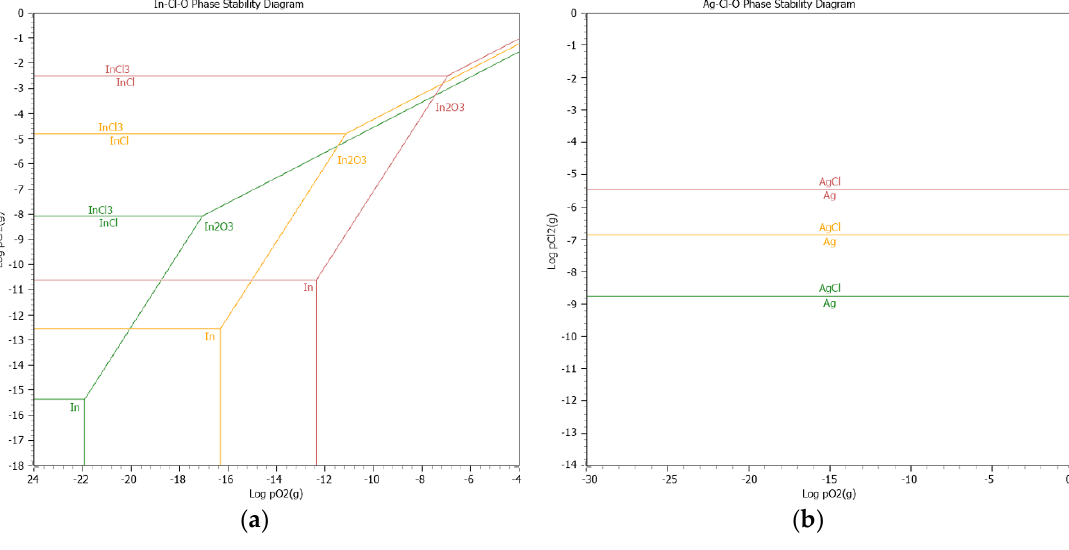
Figure 4. ( a ) Predominance diagram (Lpp) for the system O-Cl-In at three temperatures (green: 700 °C; yellow: 900 °C; red: 1100 °C) ( b ) Predominance diagram (Lpp) for the system O-Cl-Ag at three temperatures (green: 700 °C; yellow: 900 °C; red: 1100 °C).